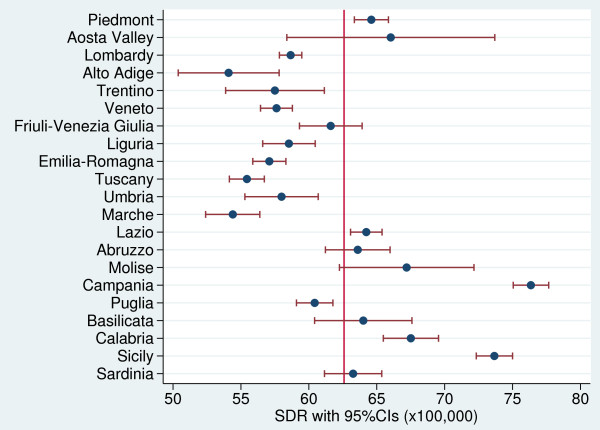
Forest plot showing the regional SDRs (with 95% confidence intervals [CIs]) in relation to the Italian average (red line) for the years 2006–08.